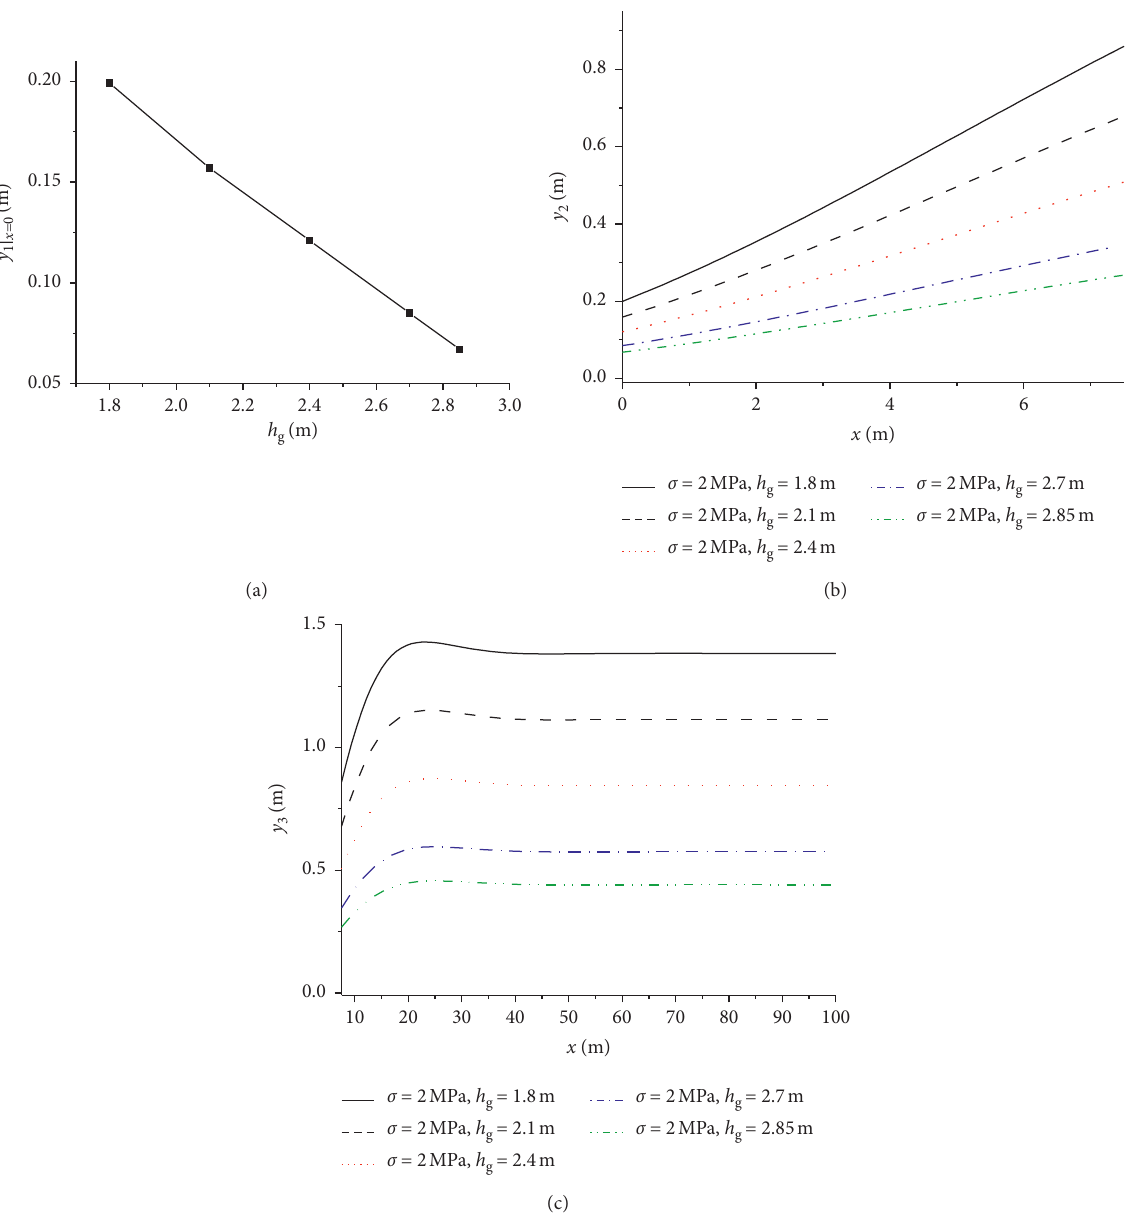
Figure 2: Roof’s subsidence amount with different h g . (a) Roof’s subsidence amount of coal wall. (b) Roof ’s subsidence amount above the support. (c) Roof ’s subsidence amount above the gangue filling